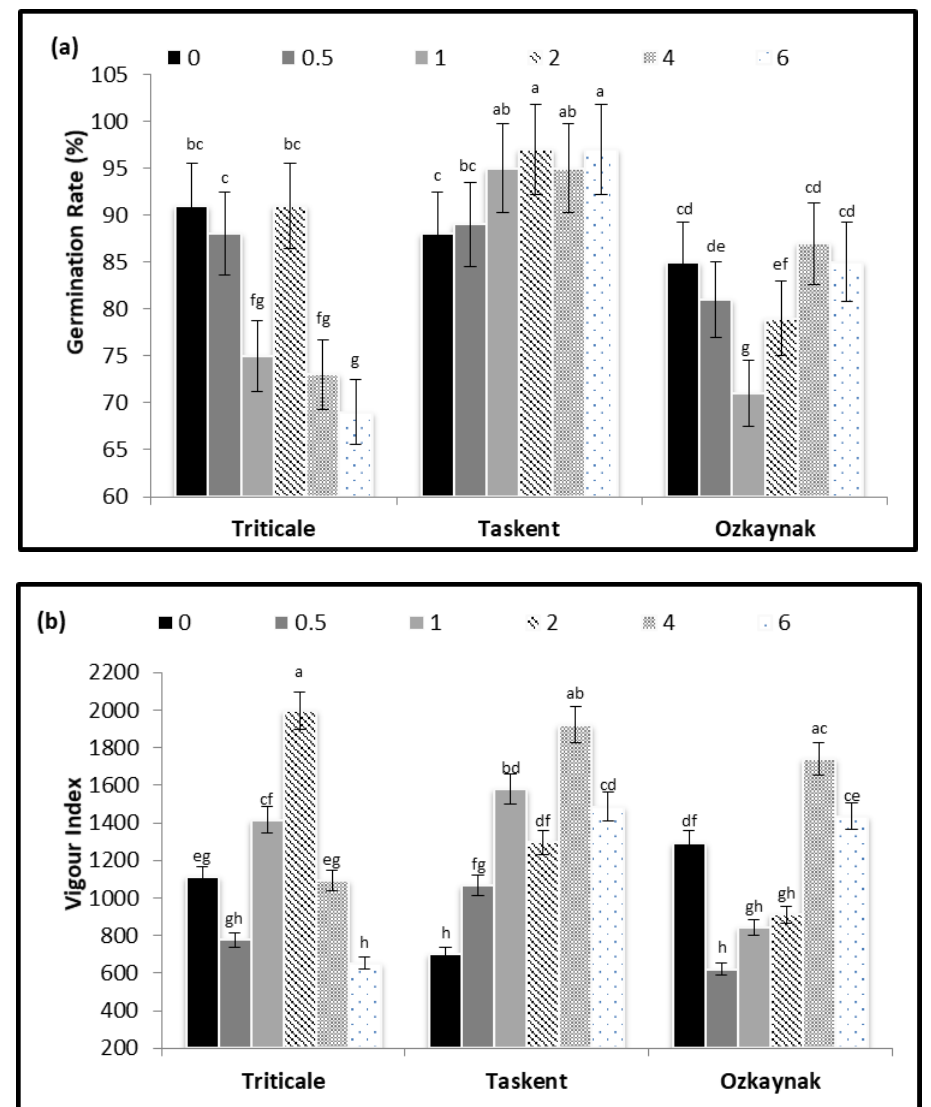
Figure 1. Effect of biochar rate on ( a ) germination rate (%) and ( b ) vigor index of Triticale, Taşkent and Özkaynak. Different letters above the bars suggested that these values are significantly different at p ≤ 0.05.